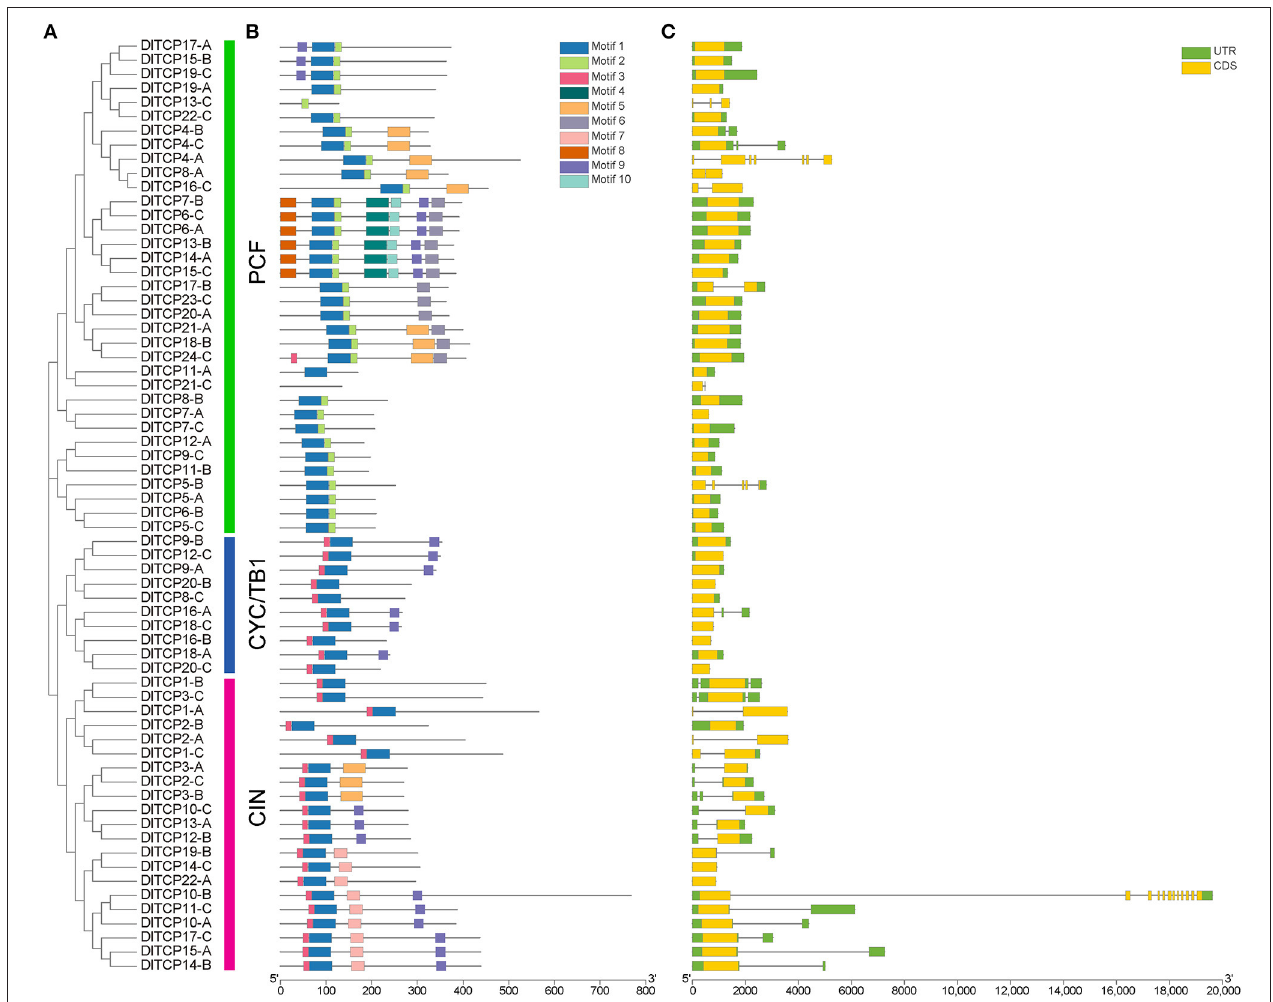
FIGURE 2 | Phylogenetic relationships, motif compositions, and gene structure of TCP genes in Ma bamboo. (A) Phylogenetic relationships of 66 TCP members in Ma bamboo. They were further classified into three subfamilies: PCF, CYC/TB1, and CIN. (B) Different motif compositions of TCP members in Ma bamboo were detected using MEME. The conserved motifs were represented by boxes with different colors. (C) Gene structures of TCPs in Ma bamboo. Green indicates 5 ′ UTR and 3 ′ UTR, yellow indicates exons, and black lines indicate introns.